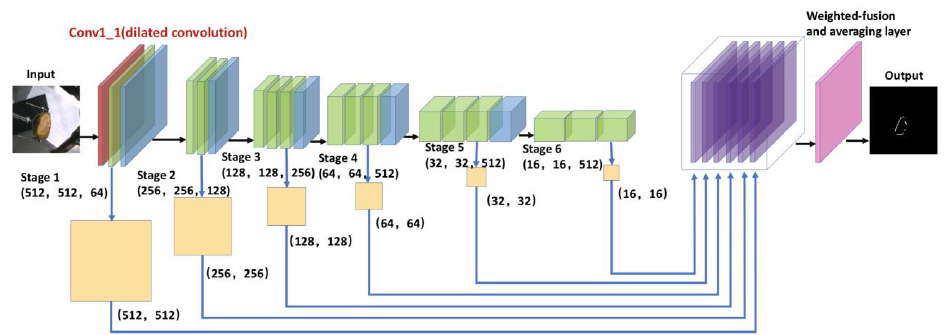
Figure 2. The structure of our model. The dark red cube represents the dilated convolution layer, the green cubes represent the convolution layer, the blue cubes represent the pooling layer, and the side-output layers are yellow. The purple cubes in the transparent cube represent the fusion of the output of each layer, and finally, a weighted-fusion layer is formed, represented by